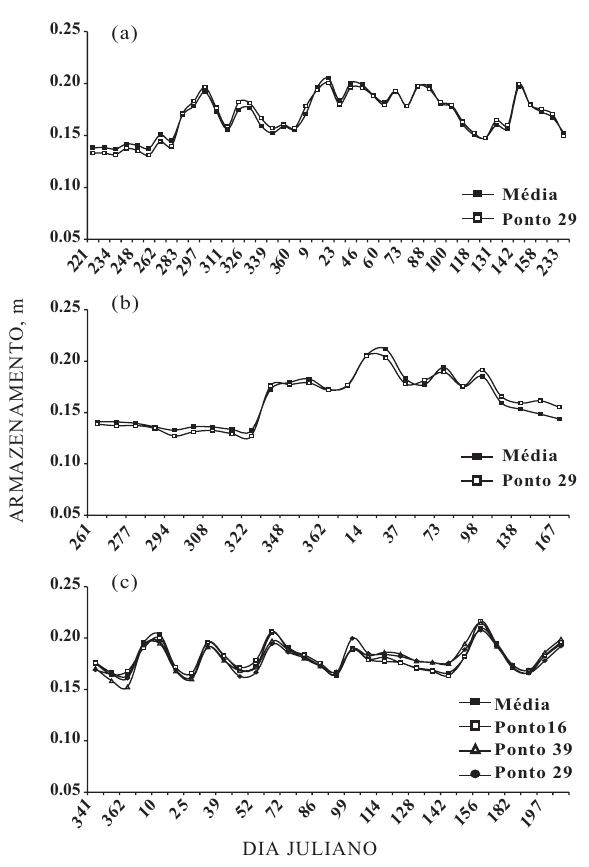
Figura 4. Comparação entre o armazenamento médio de água no solo e o armazenamento de água nas posições com estabilidade temporal para o ano 1 (a), ano 2 (b) e ano 3